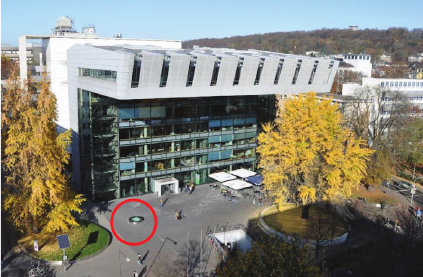
Figure 15: SuperC building with borehole cover in the red circle.